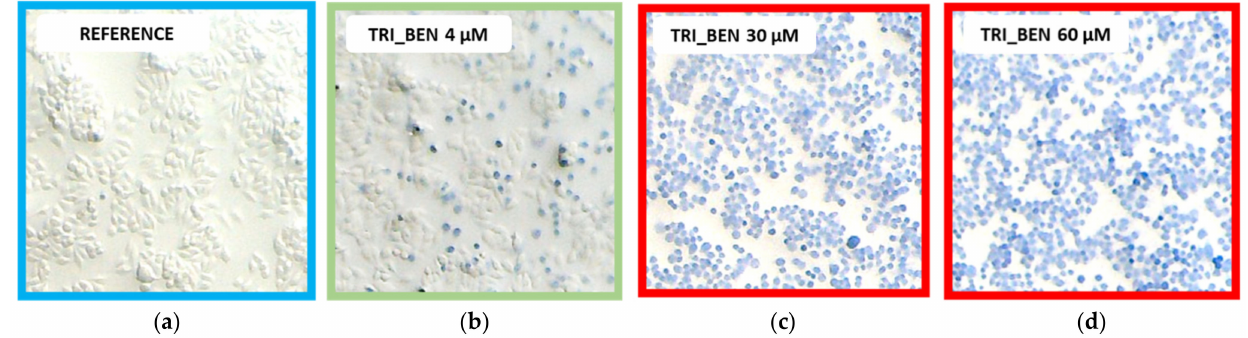
Figure 10. The results of the HeLa cells trypan blue staining after incubation with TRI_BEN. ( a ) Untreated cells and ( b – d ) with increasing concentrations of